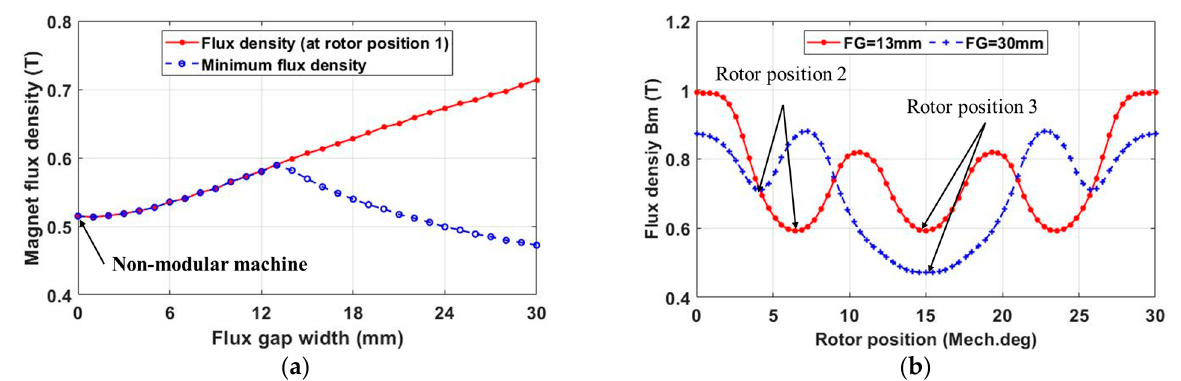
Figure 10. Magnet flux density (radial component) at point A generated by PM MMF at 20 °C for the modular machine. ( a ) Minimum magnet flux density vs. flux gap width and ( b ) magnet flux density vs. rotor position while the flux gap widths are 13 mm and 30 mm.